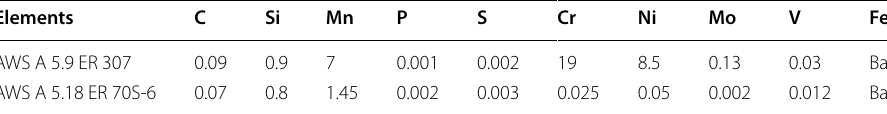
Table 3 The chemical composition of all weld metals of filler wires, wt. % Elements C AWS A 5.9 ER